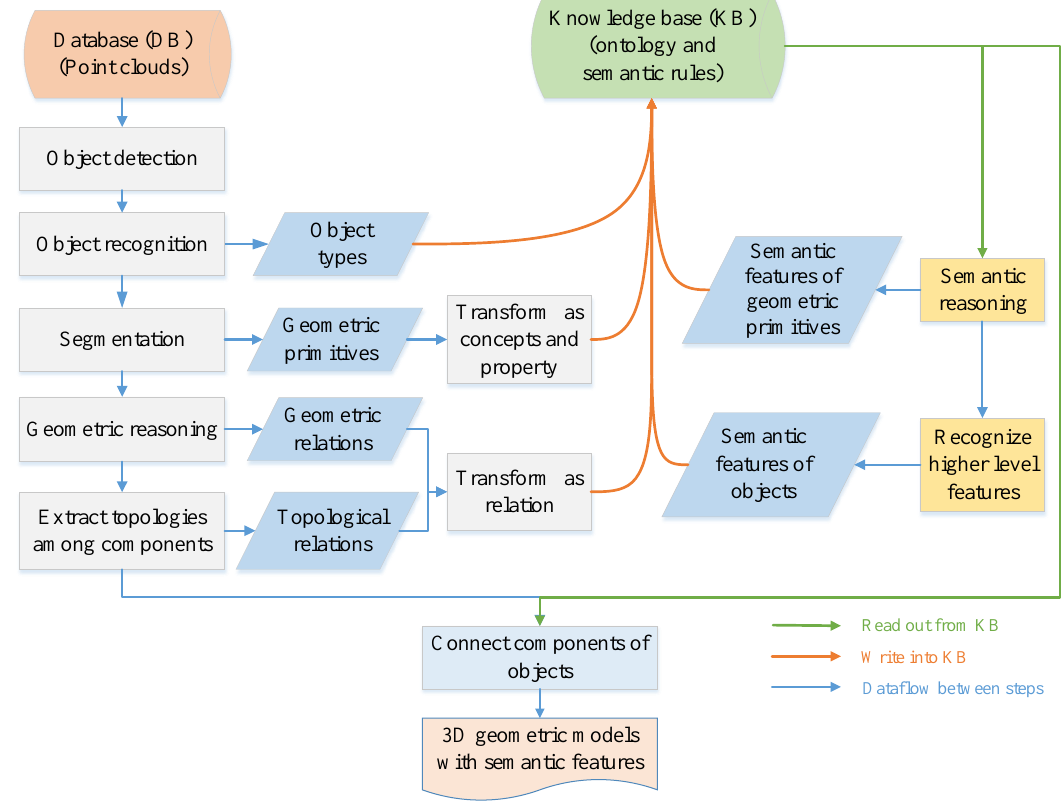
Figure 1. Proposed conceptual framework for automatic 3D modeling and feature recognition from point clouds.